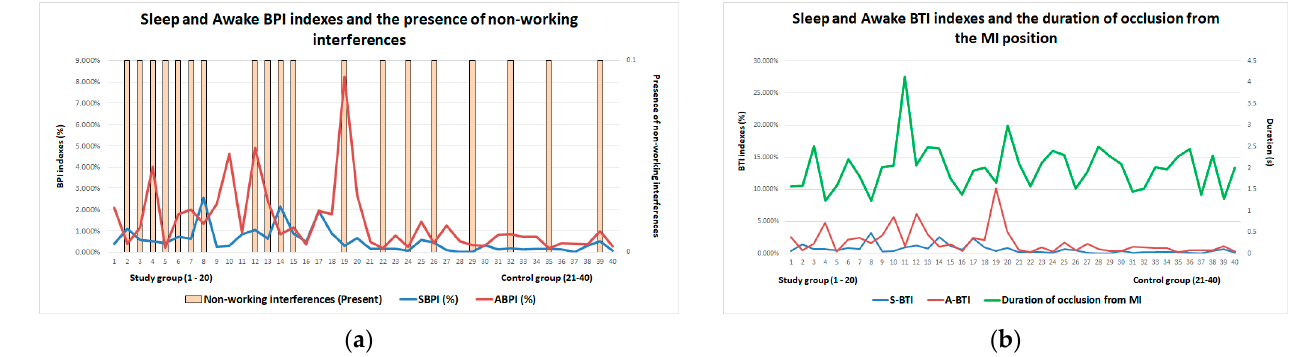
Figure 6. Graphical representation of diaBRUXO and T-Scan indexes: ( a ) Sleep and awake BPI indexes and the presence of occlusal non-working interferences in propulsion; ( b ) sleep and awake BPI indexes and the duration of mandibular movements recorded with the T-Scan system.